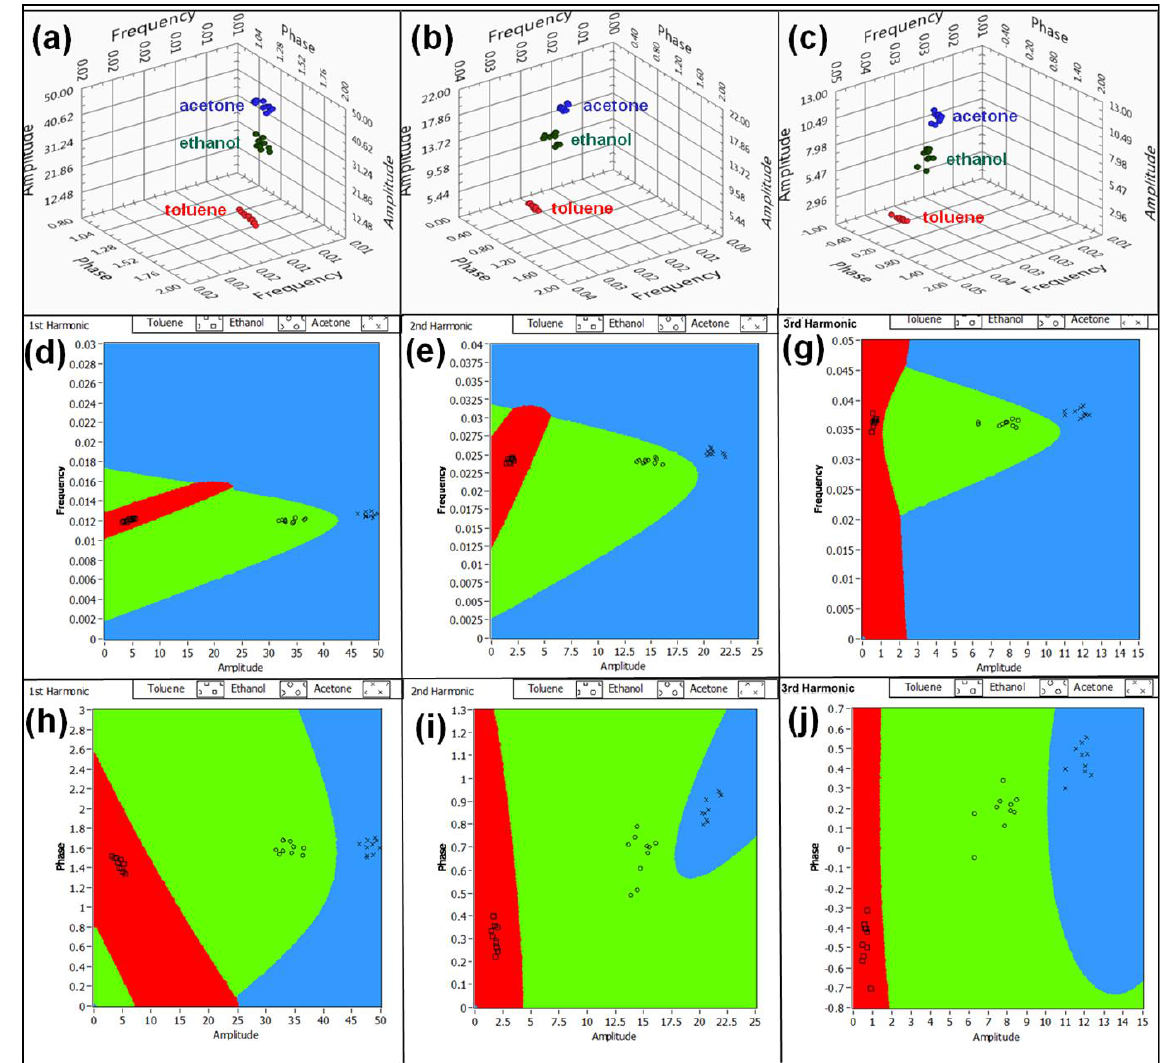
Figure 6. Visualization of the projections of 60-dimentional hyperspace (a–c). Clouds of points corresponding to different analyte exposures in 3-D (amplitude, frequency, phase) coordinate systems, corresponding to the first ( a ), second ( b ) and third ( c ) harmonics. Visualization of the quadratic discriminant analysis for the first ( d , h ), second ( e , i ) and third ( g , j )